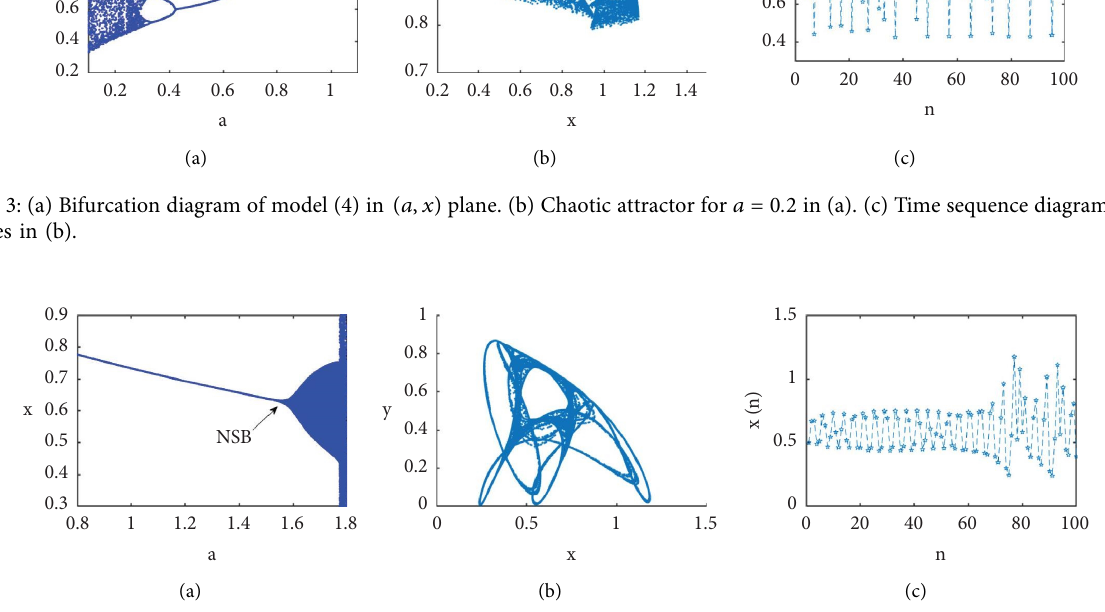
Figure 4: (a) Bifurcation diagram of model (4) in ( a, x ) plane. (b) Chaotic attractor for a � 1 . 778 in (a). (c) Time sequence diagram of prey densities in